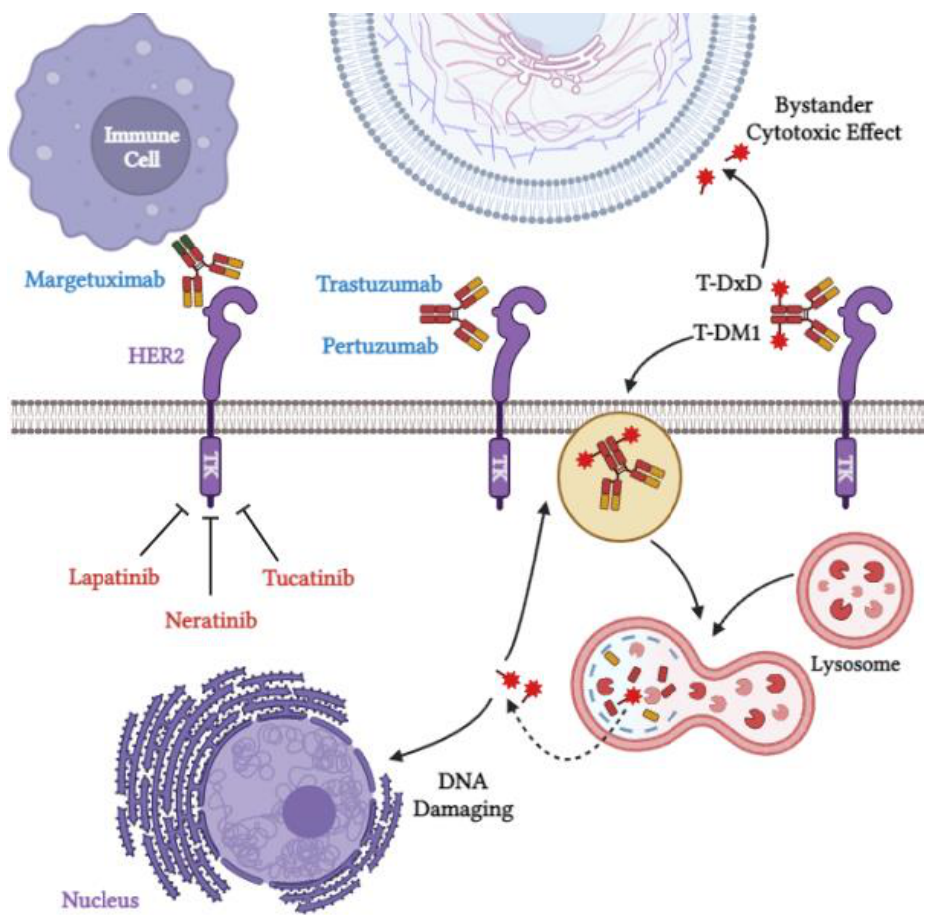
Figure 1. Mechanisms of action of some anti-HER2 therapies. Created with BioRender.com, accessed on 1 October 2020.